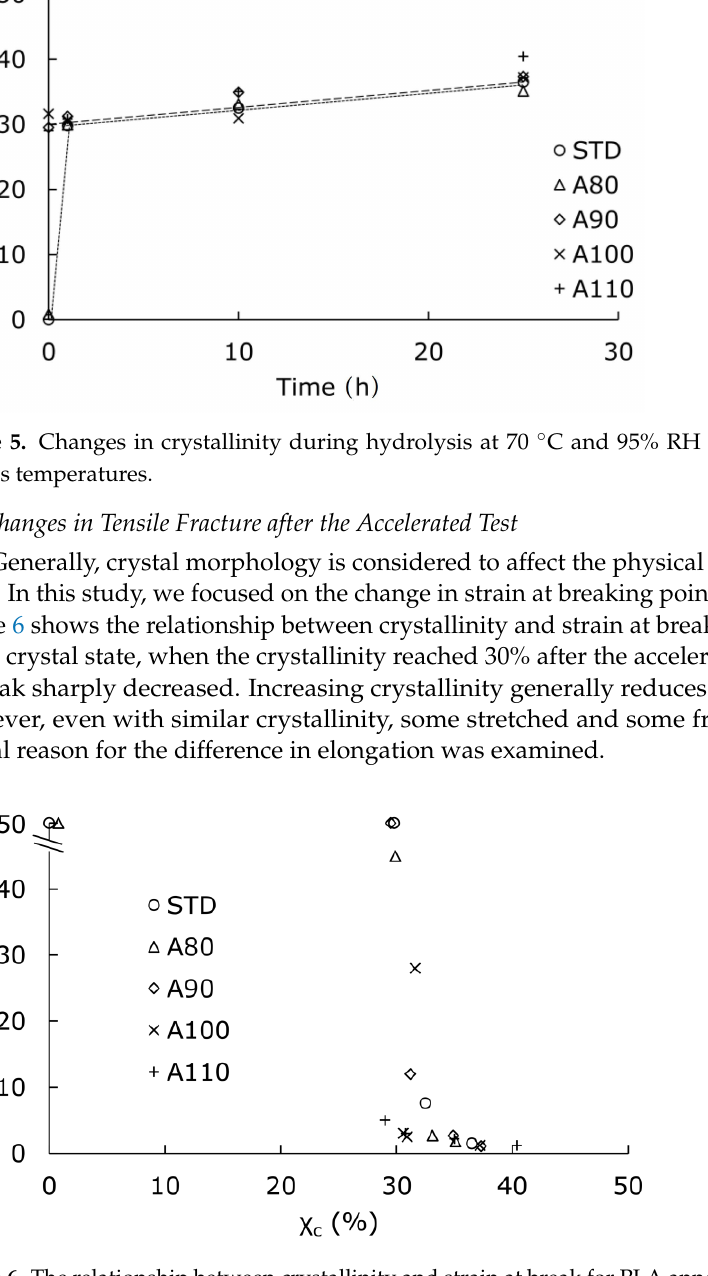
Figure 6. The relationship between crystallinity and strain at break for PLA annealed and hydrolyzed in predetermined conditions.